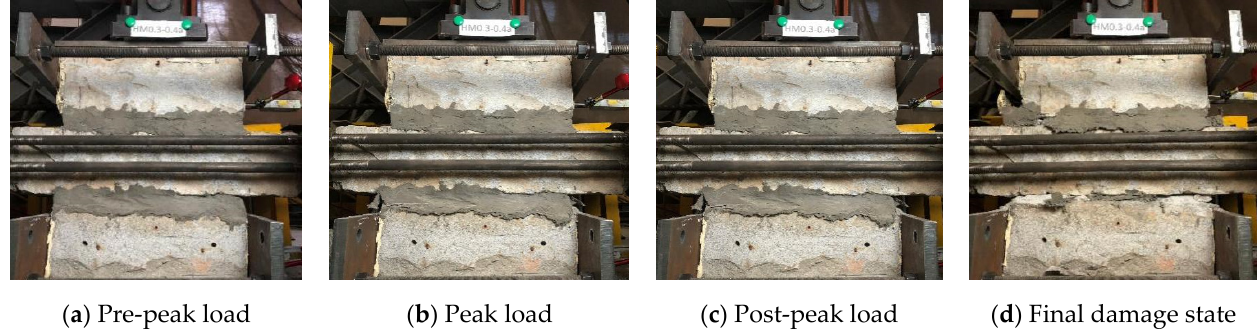
Figure 12. Typical failure process of CM specimens (CM0.3-0.4): ( a ) Pre-peak load, ( b ) Peak load, ( c ) Post-peak load and ( d ) Final damage state.